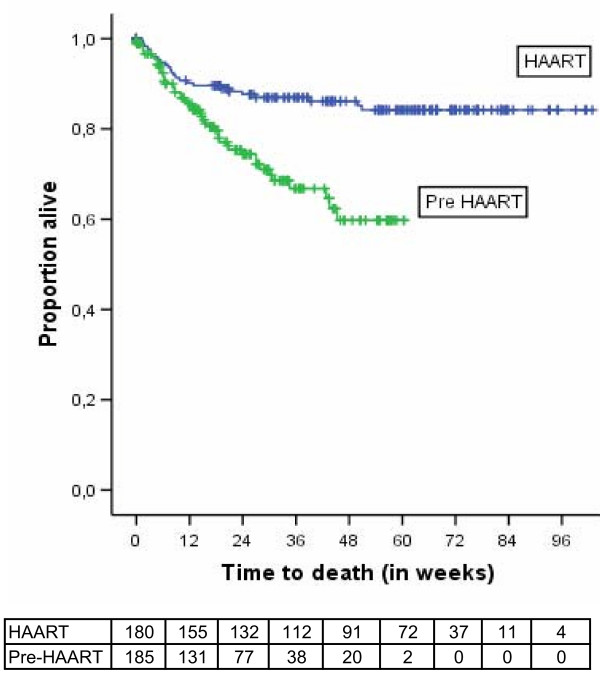
Kaplan-Meier estimates of survival with and without HAART, Arba Minch Hospital, 2006. This figure shows (i) the higher mortality rate in the untreated group, and (ii) the high early mortality in both groups. About 20 weeks after starting treatment, the mortality rate stabilized in the treated group, but in the untreated cohort there was steady increase in mortality. The longer curve of the HAART group shows the longer follow-up in the treated group.